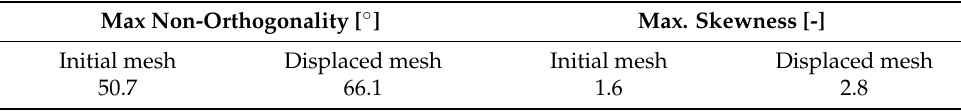
Table 4. Quality parameters of the